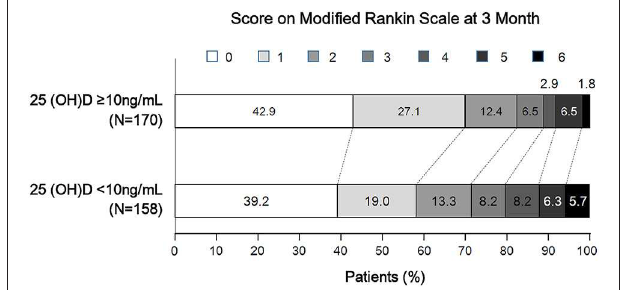
FIGURE 1 | Distribution of 3-month modified Rankin Scale score according to 25-hydroxyvitamin D deficiency status.